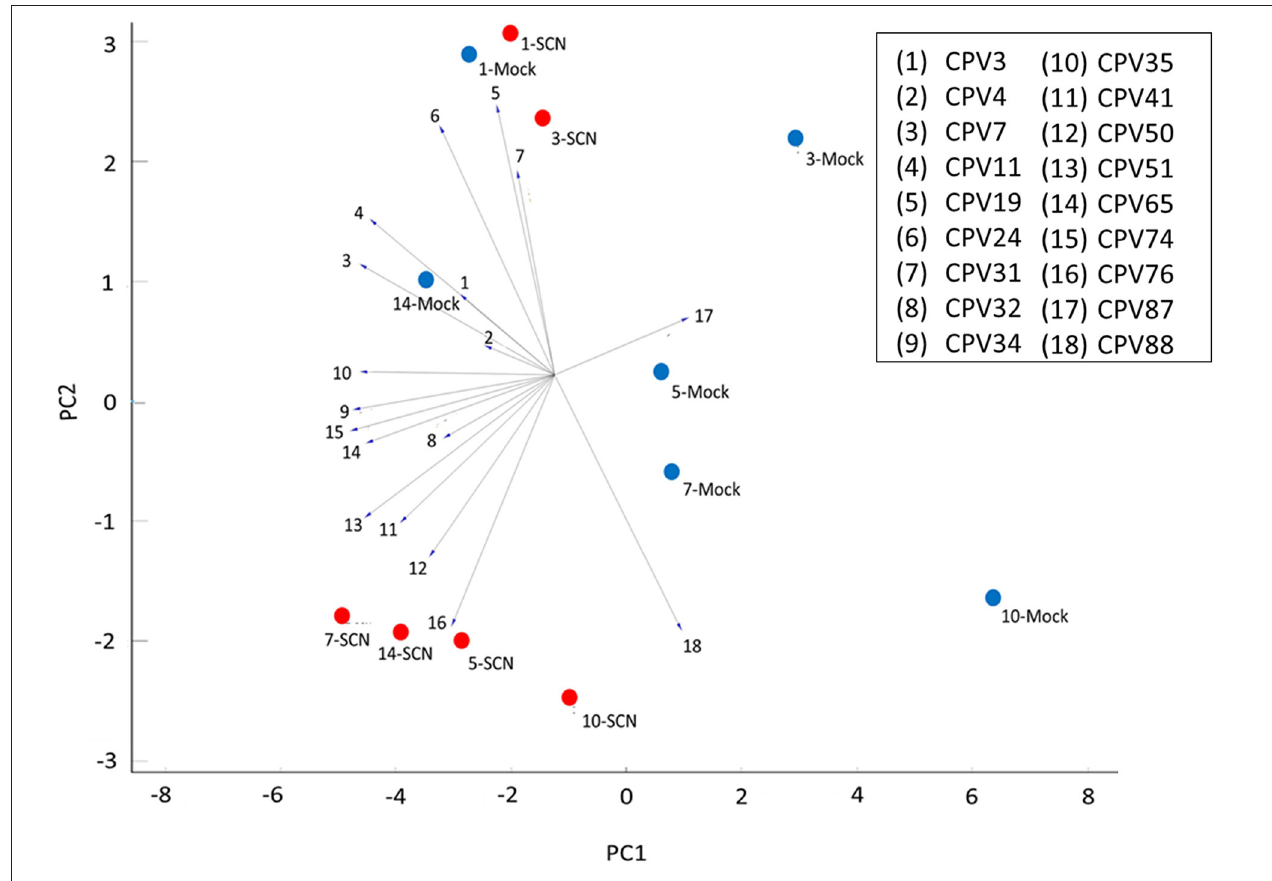
FIGURE 6 | Linear projection of principal component analysis (PCA) of identified and significant CPVs for all 6 time points. Explained variance was 60% with a cumulative variance of 0.602 and component variance of 0.195. PCA was based on 18 CPVs over 1, 3, 5, 7, 10, and 14 DAI. Mock time points are assigned blue circles and SCN time points are assigned red